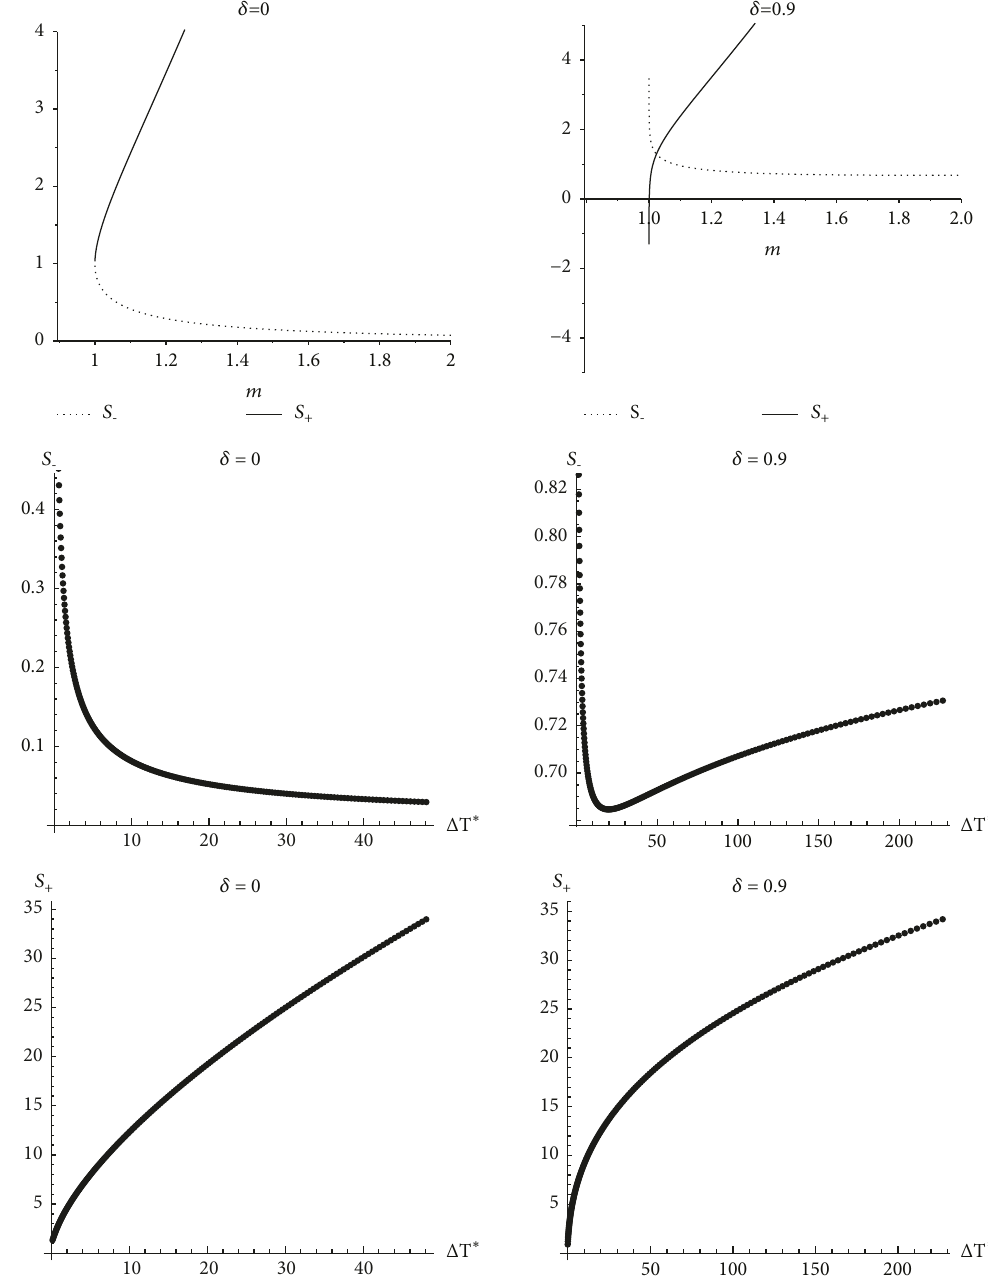
Figure 4: Diagram of 𝑆 ± is plotted against 𝑚 and Δ𝑇 ∗ for 𝛿 = 0 and 𝛿 = 0.9 .